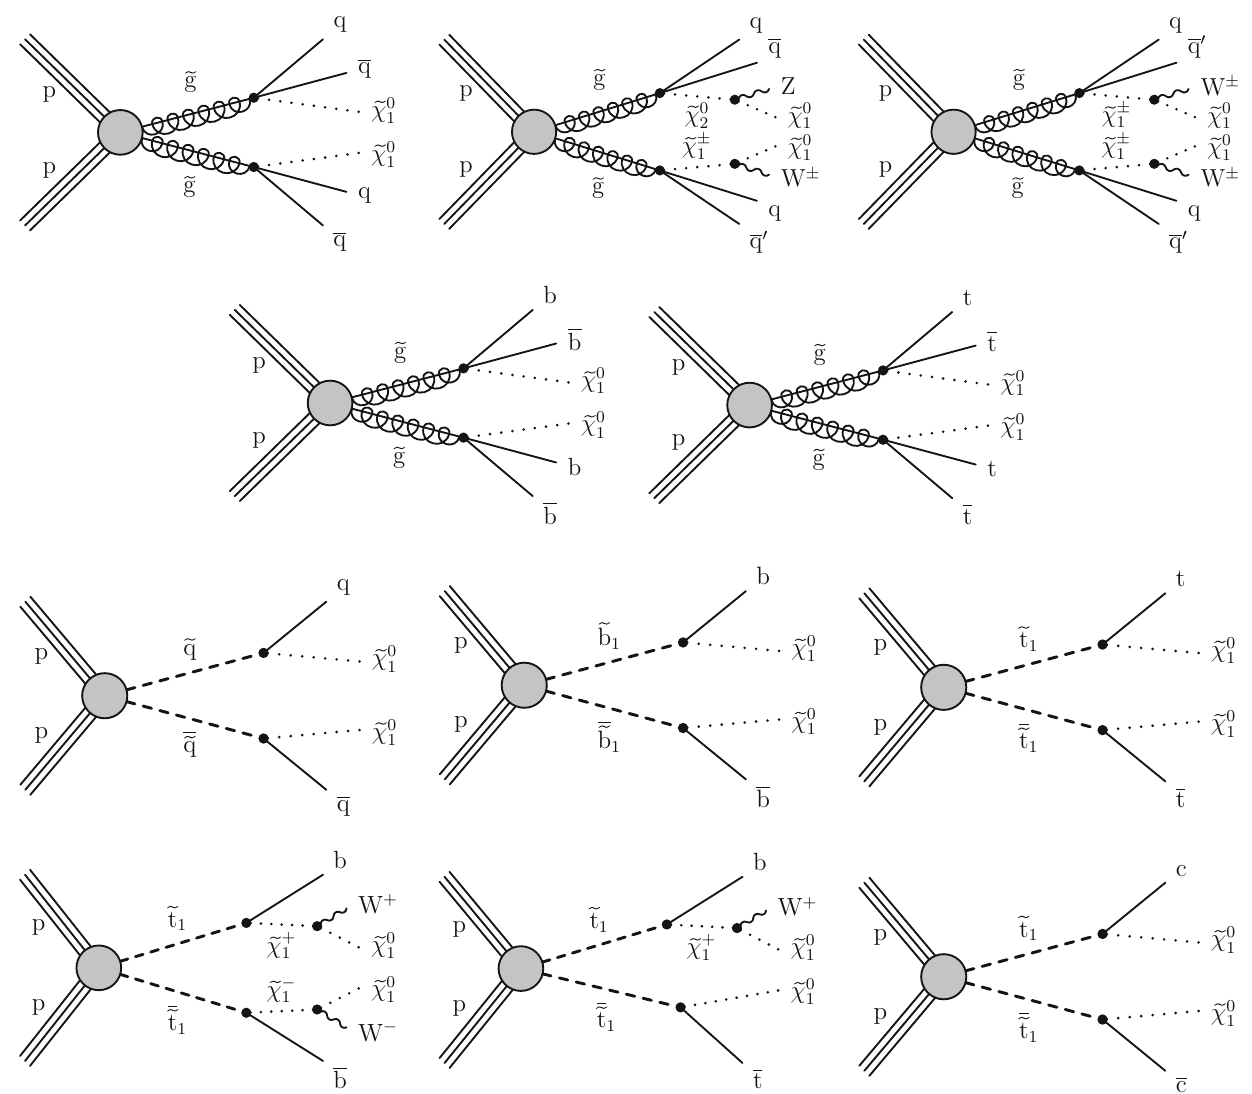
Fig. 7 (Upper) Diagrams for three scenarios of direct gluino pair pro- duction where each gluino undergoes a three-body decay to light-flavor (u, d, s, c) quarks, with different decay modes. For mixed-decay scenar- ios, we assume equal branching fraction for each decay mode. (Upper middle) Diagrams for the direct gluino pair production where gluinos